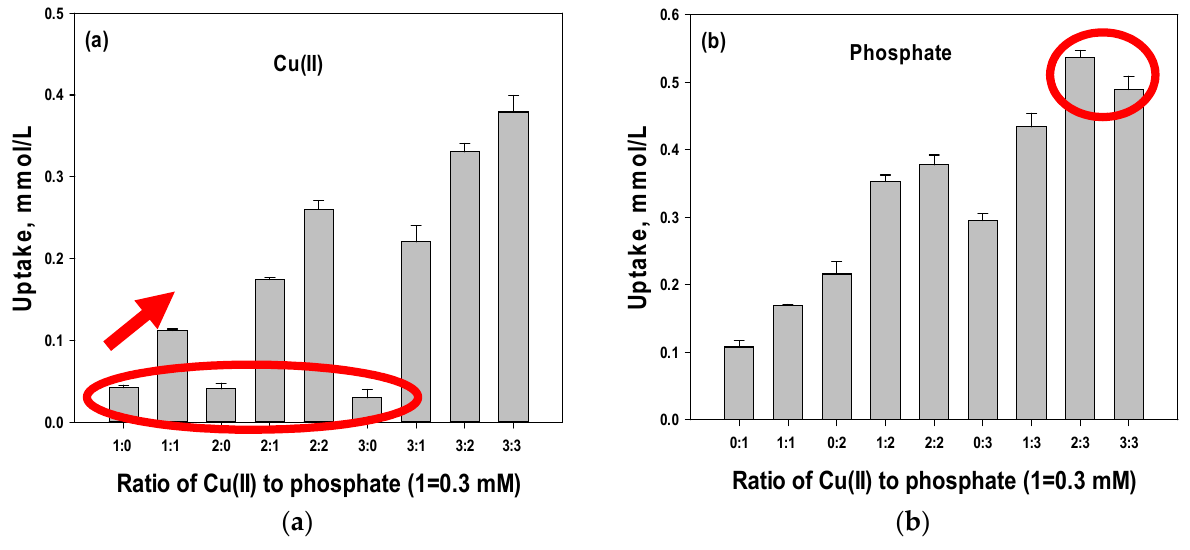
Figure 2. Uptake of Cu(II) ( a ) and phosphate ( b ) at different initial concentrations. To investigate whether these results were due to the effect of Cu(II) and phosphate species at increased initial concentrations, the species were calculated using Visual MINTEQ 3.1 at a fixed pH of 5.25 (Table 1). Since the dominant species of Cu(II) and phosphate were Cu 2+ and H 2 PO 4 − (94.3% and 93.7%, respectively), in all cases, the effect of the species could be ignored.